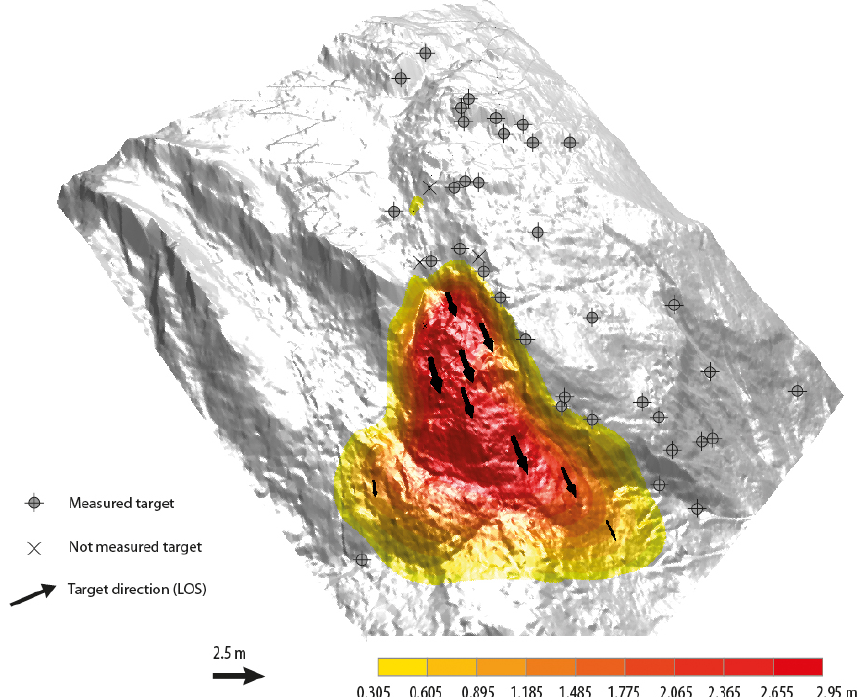
Figure 5. Map representing the displacement registered along the line of sight direction using the RTS and GB-SAR data. The LOS com- ponent measured by the different instruments is plotted in the same displacement map to have a more complete record of the ground displacements. This solution gives the possibility to have high resolution and compensate RTS measurements with 16 points derived from GB-SAR and located in the most inaccessible sectors where the installation of RTS target is not